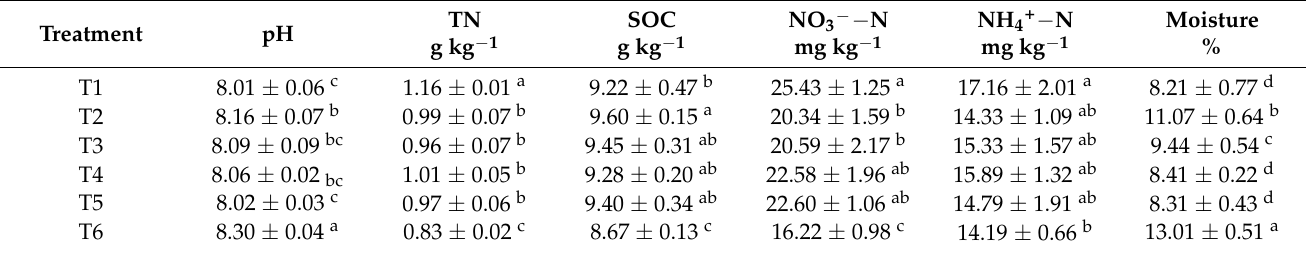
Table 3. Soil physicochemical properties at the flowering stage of maize supplied with different ratios of organic and inorganic